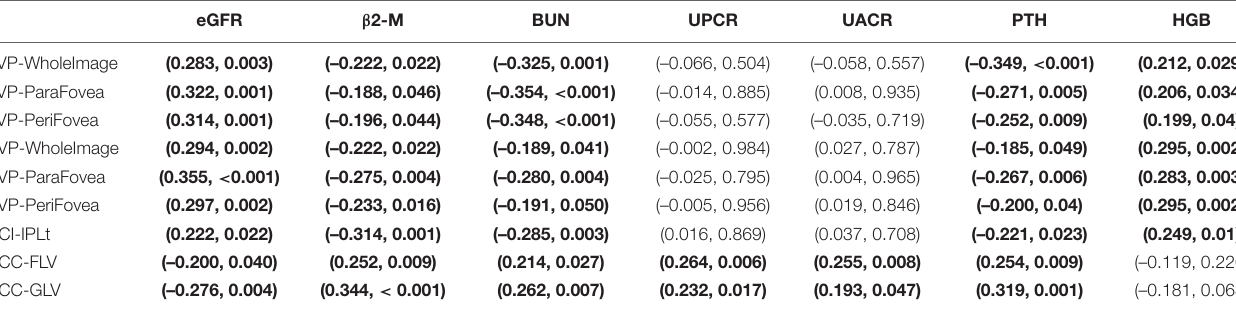
TABLE 4 | Partial correlation between OCTA parameters and CKD-related data (115 CKD